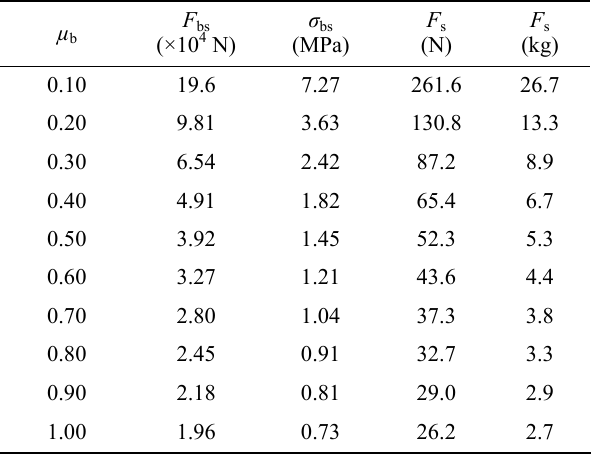
Table 2 Estimation of normal force “ F s